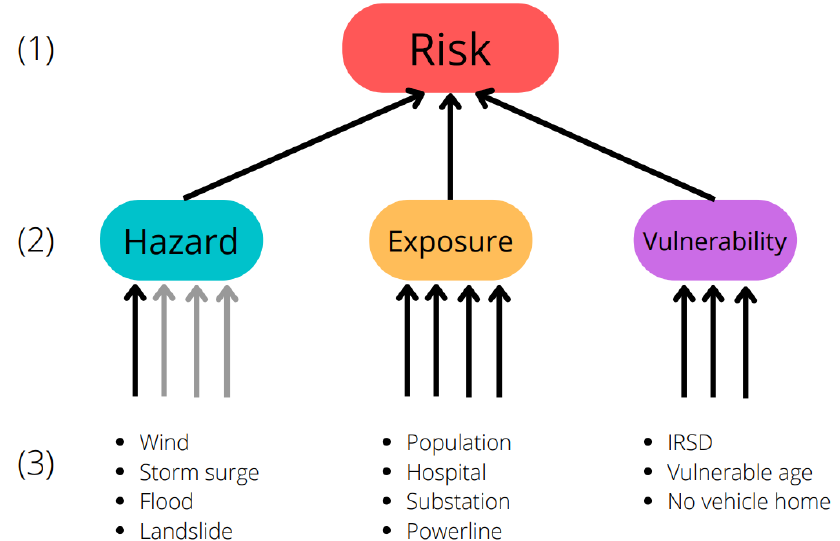
Figure 3. Risk index flowchart where (1) represents the risk index, (2) represents the three indices, and (3) represents the indicators used to build each index. Four hazard-specific risk layers are produced for each TC-induced hazard.